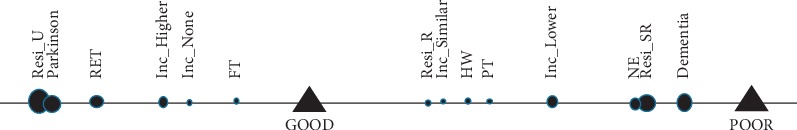
Projection of correspondence analysis. ∗Resi_U, urban residence; RET, retired; Inc_Higher, above average income; Inc_None, no income; FT, full-time job; Resi_R, rural residence; Inc_Similar, income similar to average; HW, housewife; PT, part-time job; Inc_Lower, lower-than-average income; NE, nonemployed; Resi_SR, semirural residence.